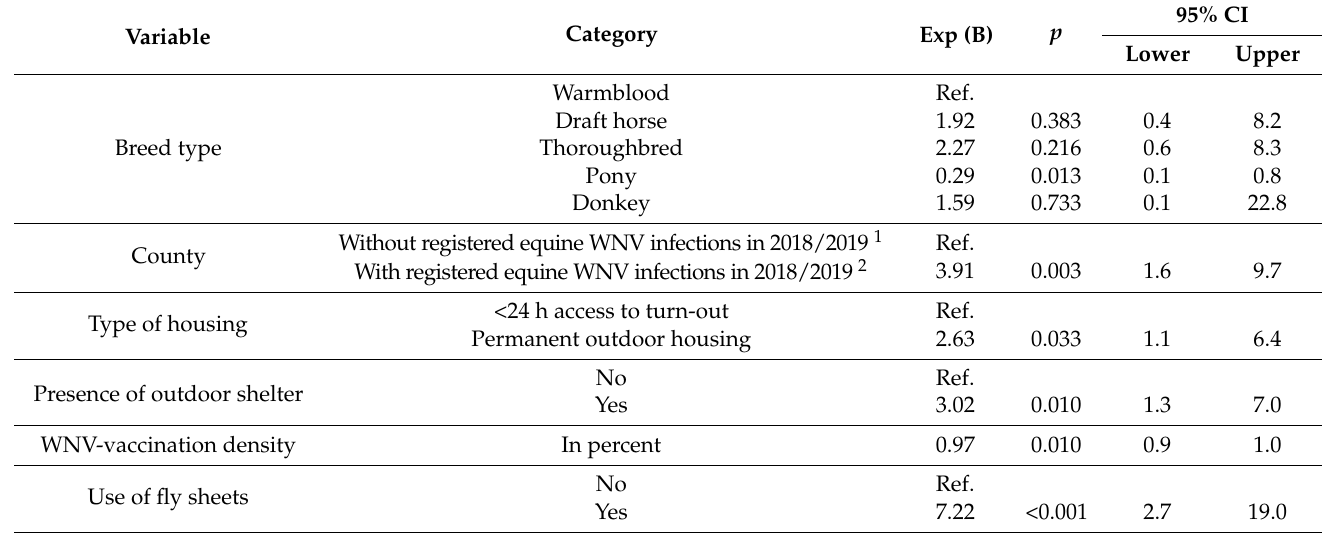
Table 3. Logistic Regression model for the association of potential risk factors with WNV seropositiv- ity in 937 horses in Eastern Germany. Only variables with significant categories ( p < 0.05) are